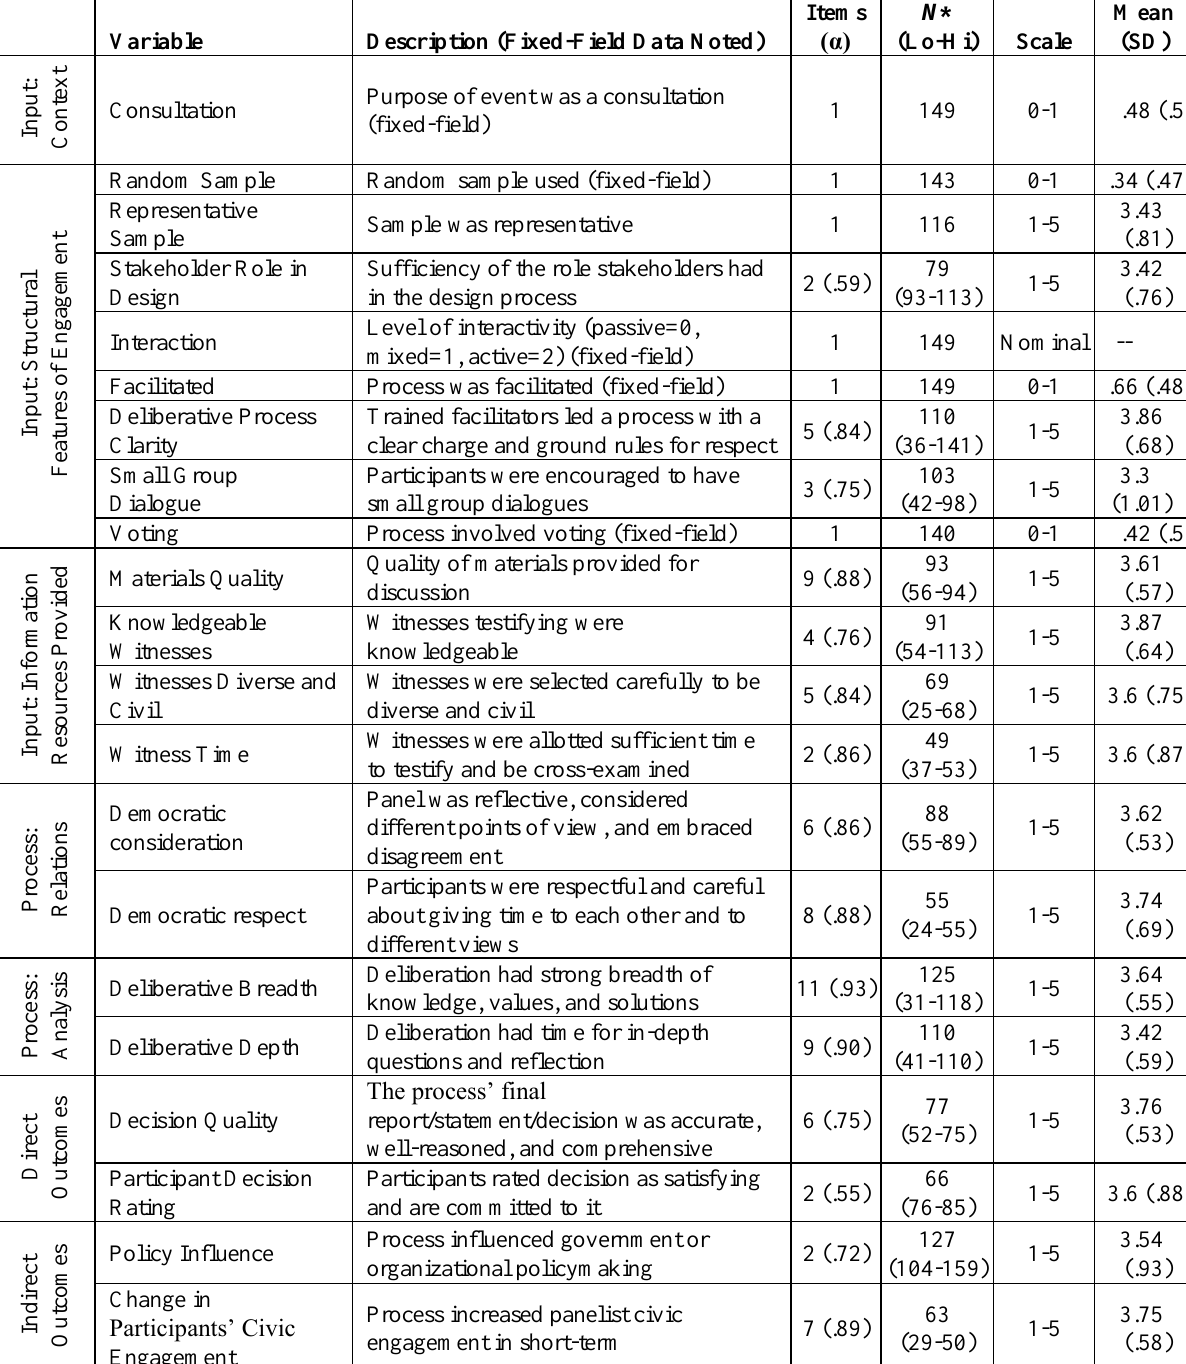
Table 1. Variables from Participedia Fixed-Field Data and Coded Case Narratives